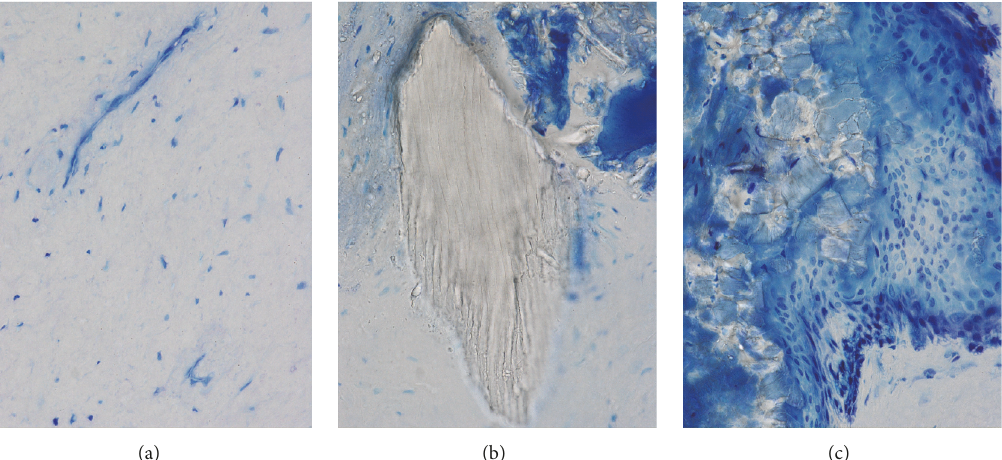
Figure 7: Details of the “ghost” teeth C and D under light microscope (a–c): (a) mesenchymal-like tissue; (b) dentine fragment; (c) odontoblast-like cells (red arrow) that appear to be in a phase of matrix deposition around calcified granules (yellow arrow). Toluidine Blue and Pyronin Y staining, total magnification